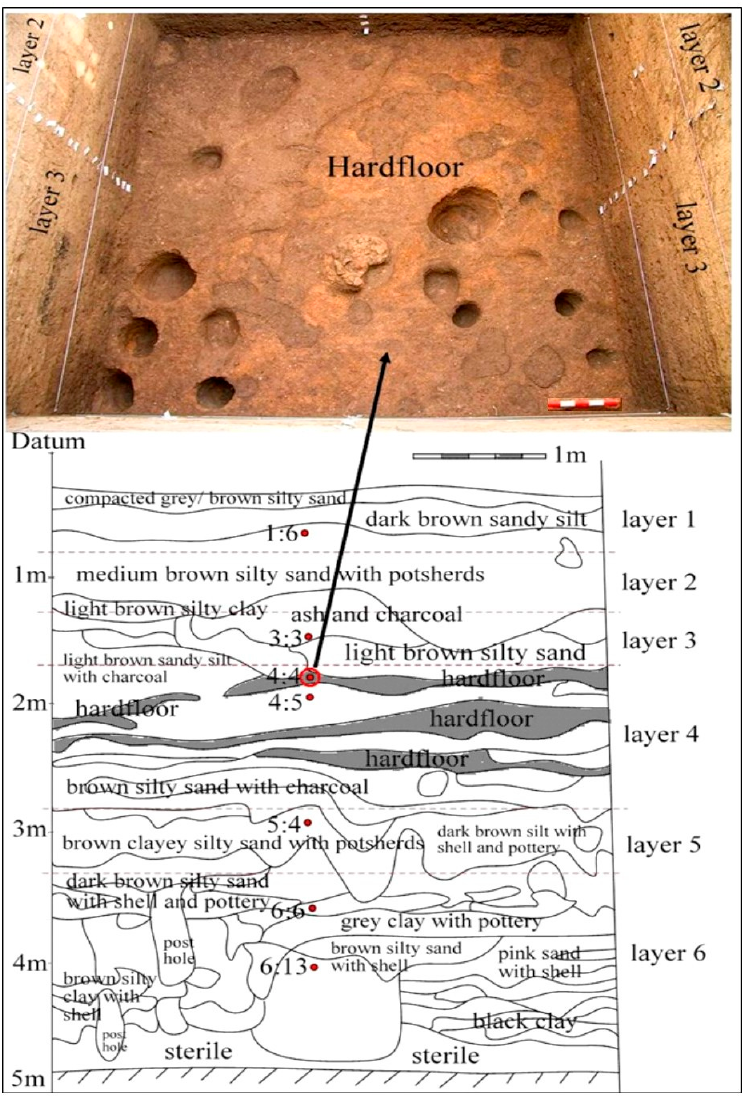
Figure 4. Stratigraphy of N96 sampling context (red dots indicate the sampling context; layer number: spit number). (Photograph: Nigel Chang; Line diagram: Nelum Kanthilatha).